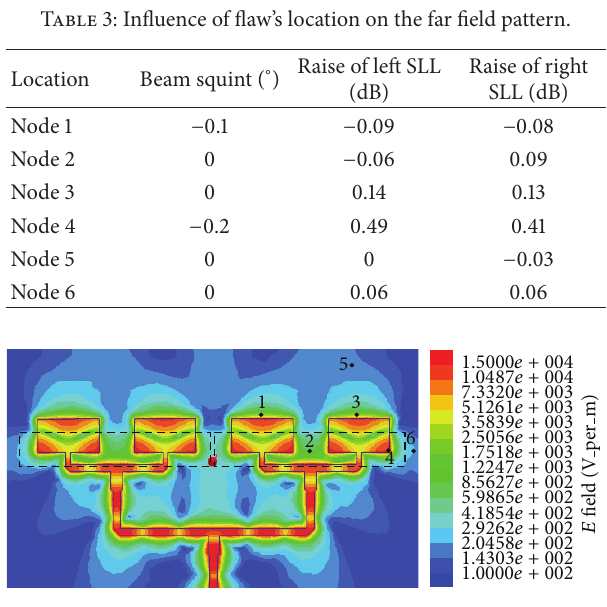
Figure 7: Distribution of the electric field on the microstrip antenna array by